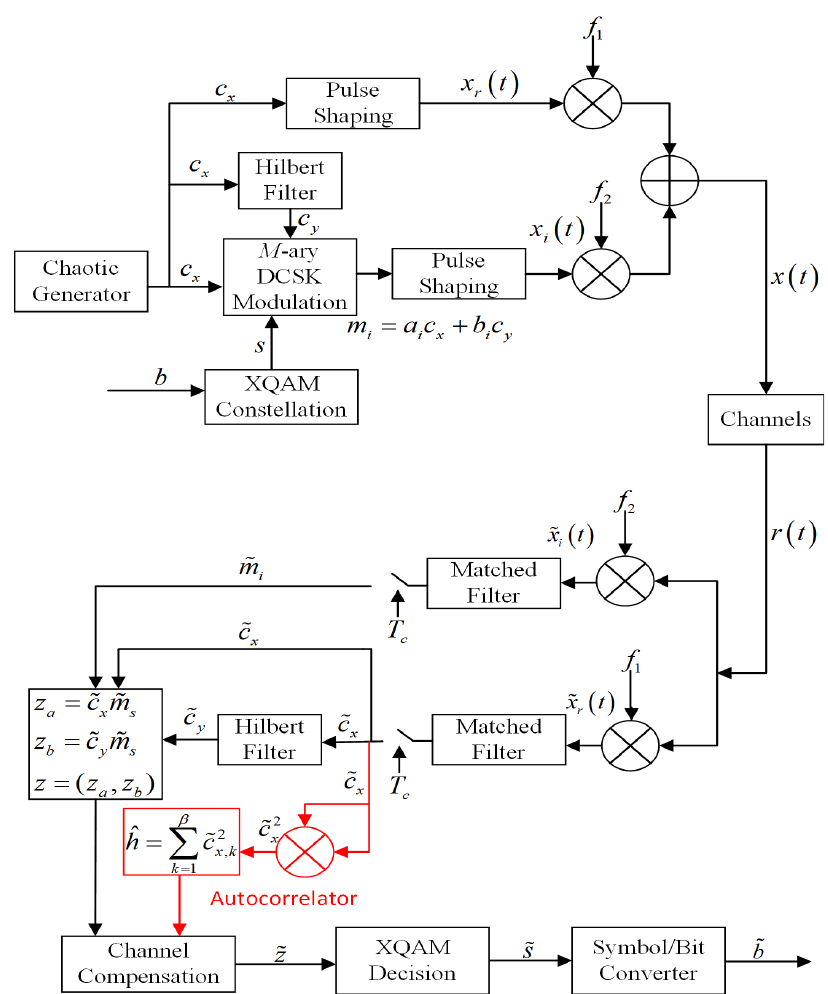
Figure 1. The proposed non-coherent XQAM- M DCSK